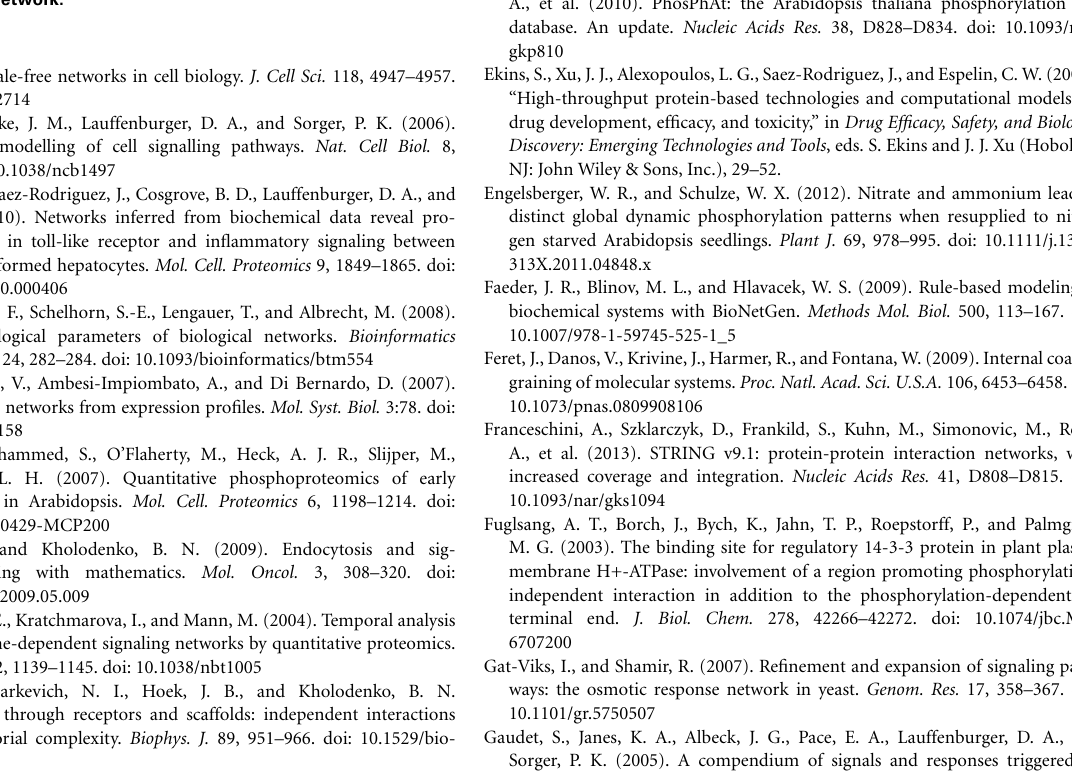
Table S1 | Reconstructed network summary (number of nodes, number of interactions, and average degree) for each treatment, which was then combined into an integrated “super-“network. Table S2 | List of top 20 nodes (phosphoproteins) with highest degree in the reconstructed